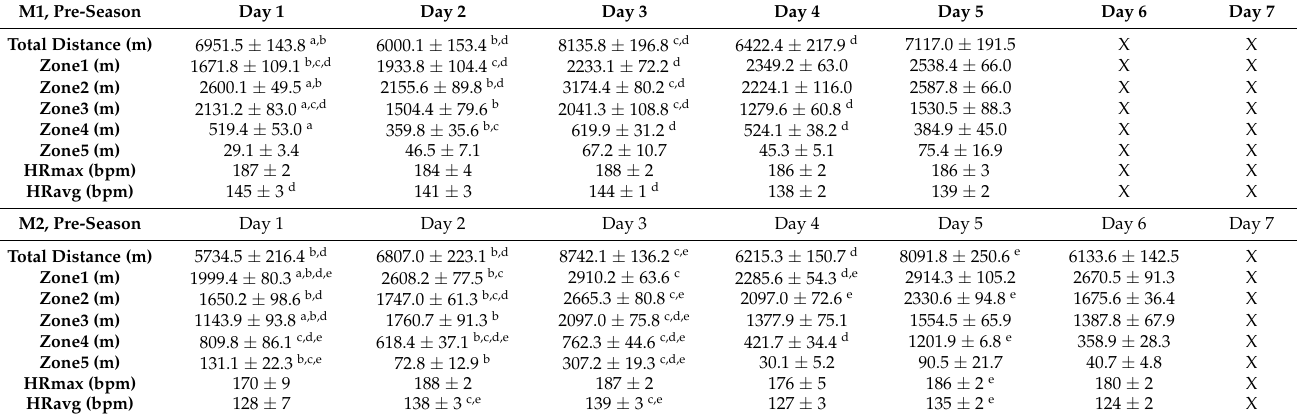
Table 3. Distances covered at different speed thresholds and heart rate variables (representative of squad average data) during the 7-day period in